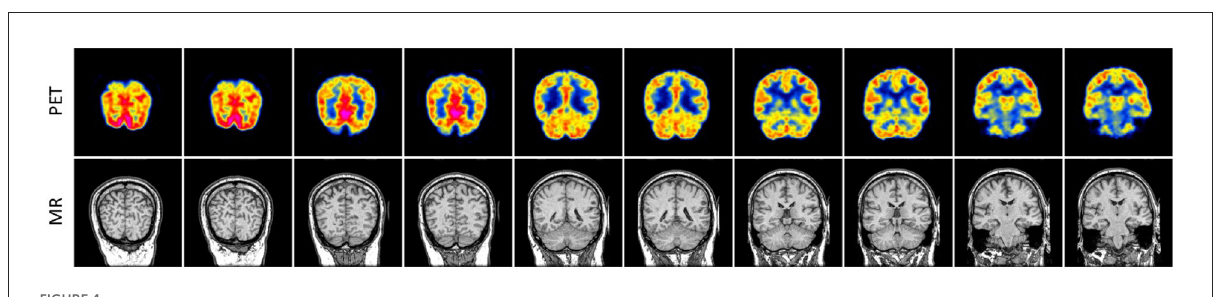
FIGURE4 Ten pairs of images in the PET-MR image dataset.